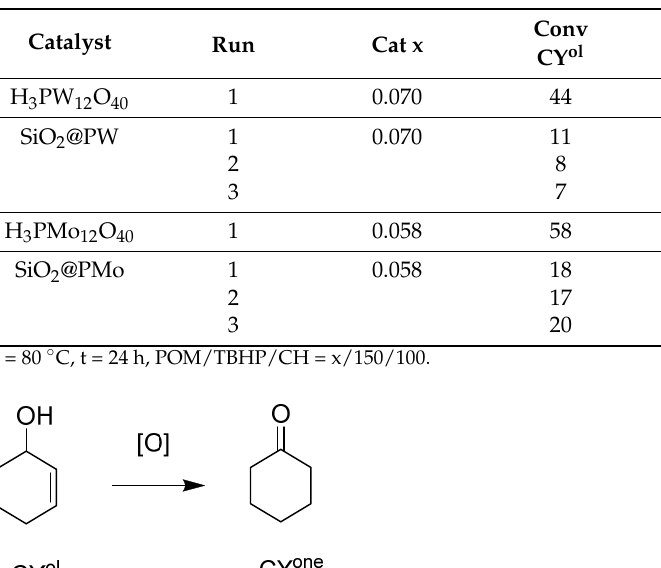
Table 16. CY ol oxidation toward CY one with heteropolyacids and corresponding anionic species grafted on silica schemed in Figure 22. Studied products are those from Figure 27.